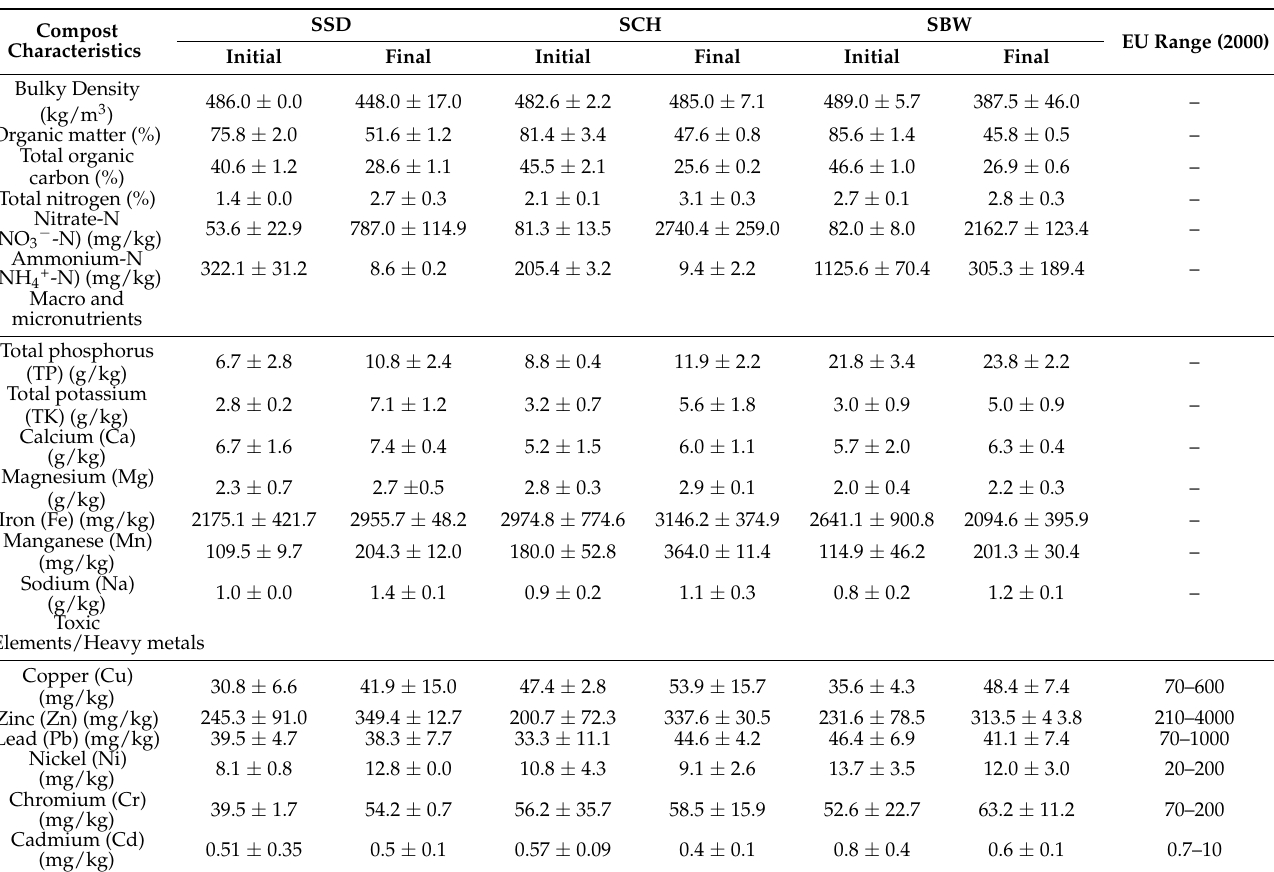
Table 2. Nutrient and heavy metals concentrations of initial feedstock and mature compost of FS with different bulking